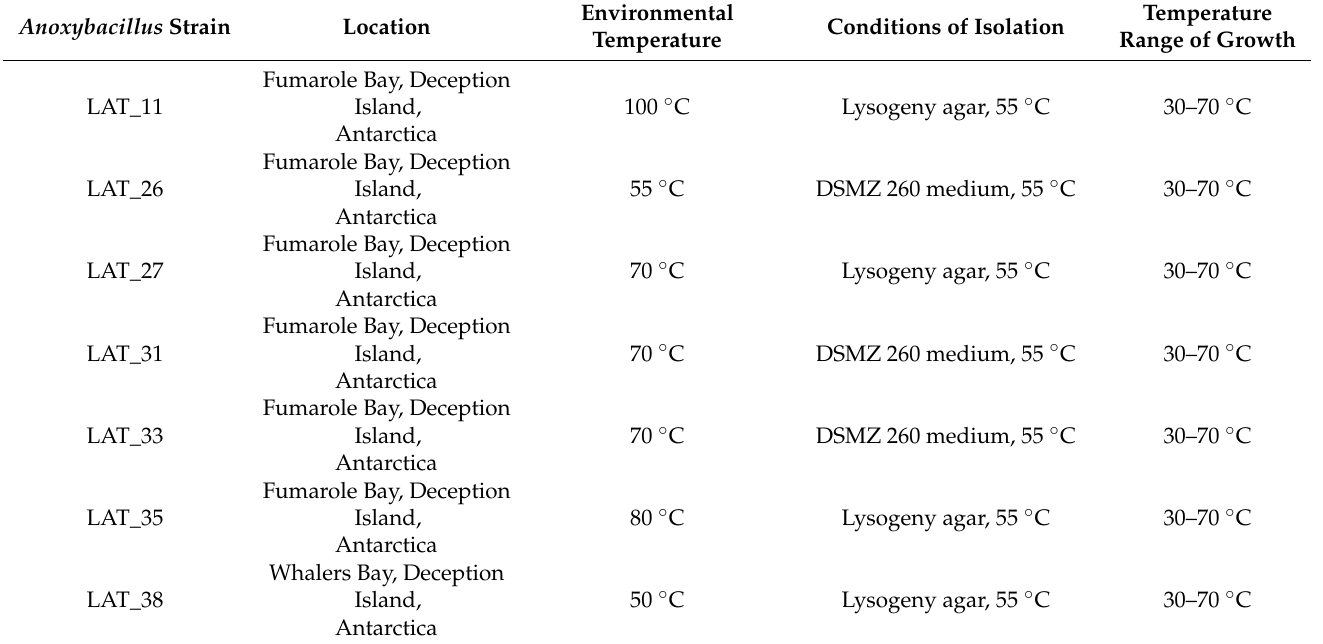
Table 1. Characteristics of the seven bacterial strains previously identified as belonging to the Anoxybacillus genus isolated from both geothermal sites on Deception Island,